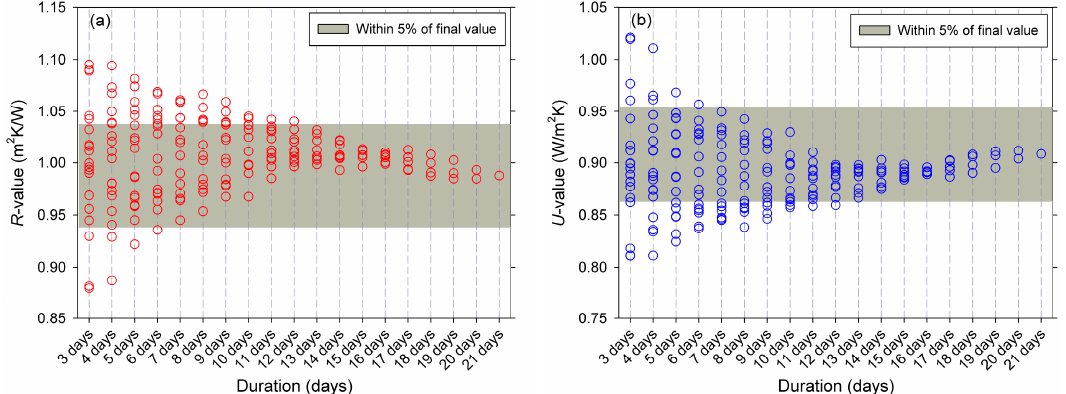
Energies 2019 , 00 , 0000 FOR PEER REVIEW Figure 5. Distributions of ( a ) R -values and ( b ) U -values evaluated for different analysis periods.